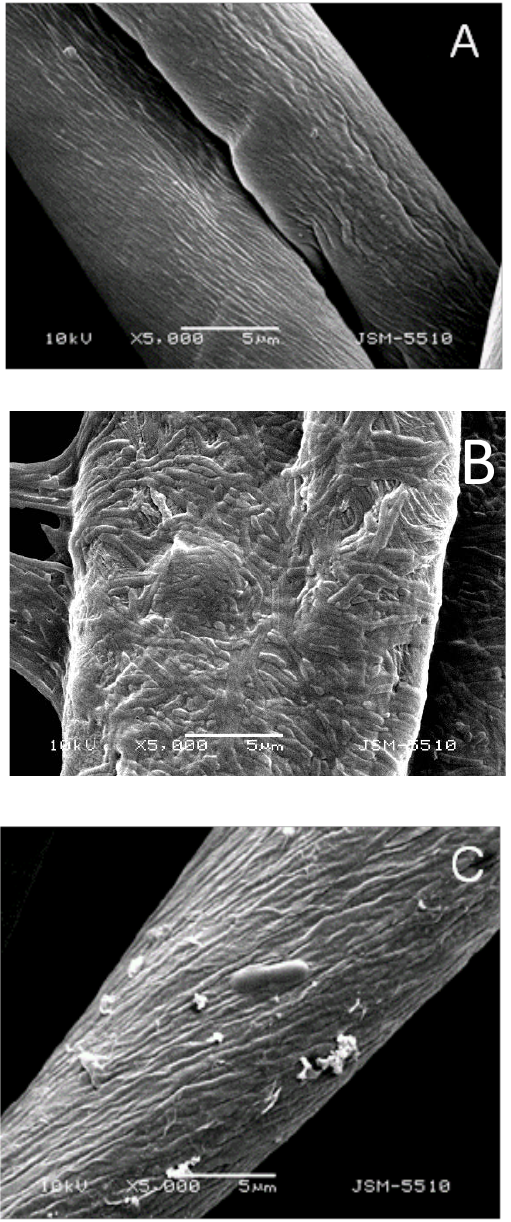
Figure 6. Scanning Electron Microscopy (SEM) micrograph of cotton fabrics tested against P. aeruginosa at magnification X 5000: ( A ) Cotton textile before treatments; ( B ) biofilm on untreated cotton textile; ( C ) absence of biofilm on cotton textile treated with [Cu 2 (ACR)(NO 3 ) 2 ]; ( D ) reduced biofilm